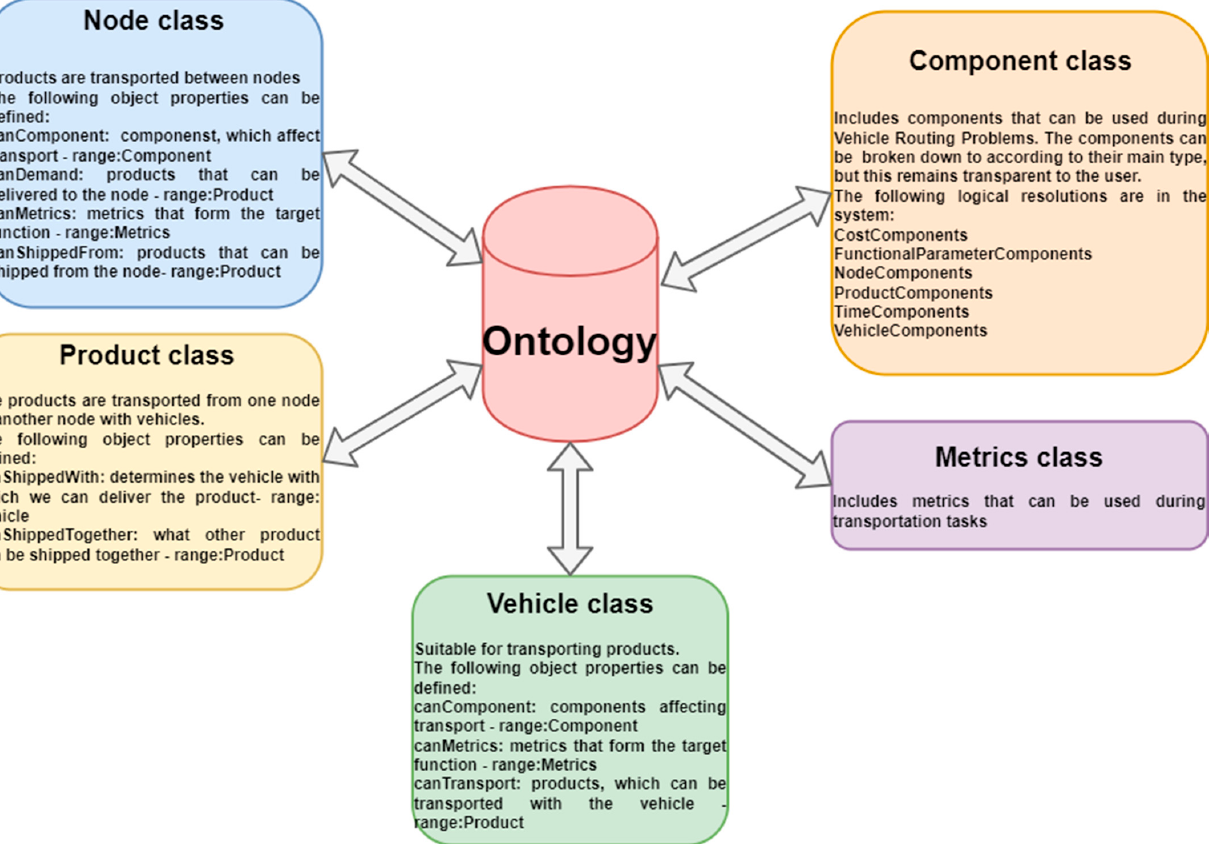
Figure 2. The ontology system.